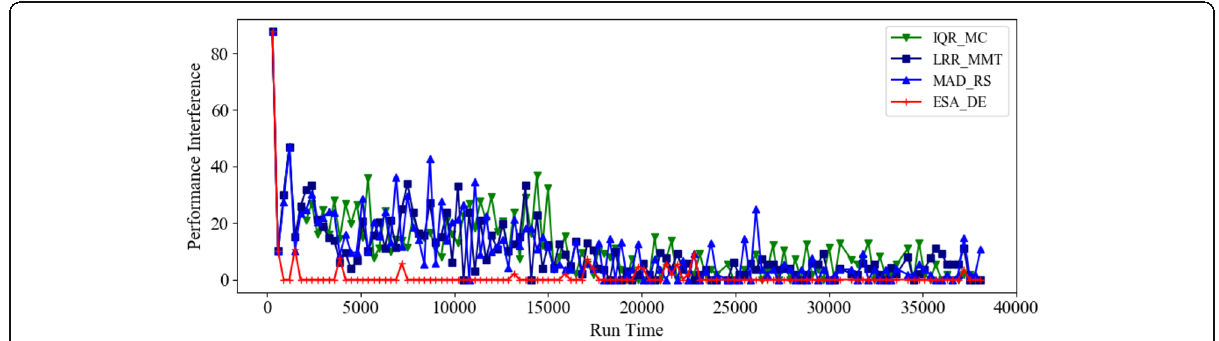
Fig. 9 Performance interference of virtual machine migration at different